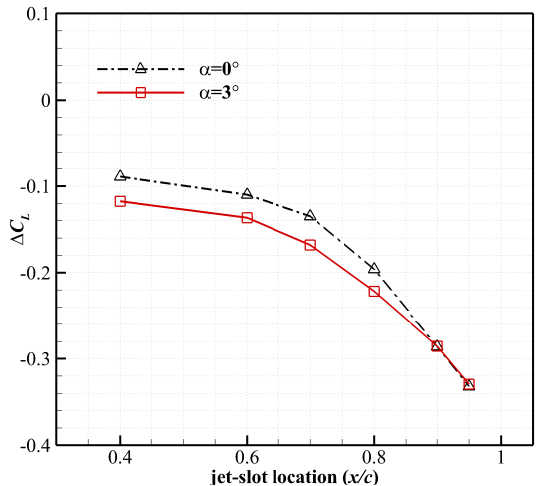
Figure 3. Influence of Microjet location on lift coefficient reduction with M jet = M ∞ = 0.3 (from [30]).